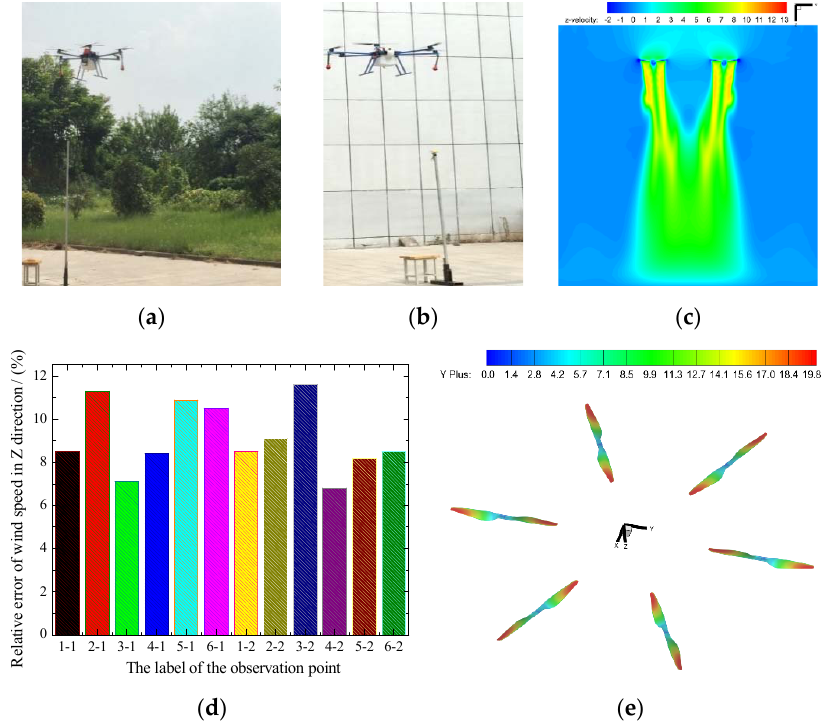
Figure 4. Reliability verification of wind field model: ( a ) Wind speed test preparation; ( b ) Test of z-direction speed under the rotor; ( c ) Calculation cloud map of z-direction velocity of the longitudinal section below rotor; ( d ) Relative error of z-velocity calculation and test; ( e ) The y+ cloud map of the rotor wall after the wind field calculation is stabilized. Table 1. Comparison of calculated and designed values for rotor lifts in different load conditions. Simulated Lift Values of Single Rotors Load (kg)